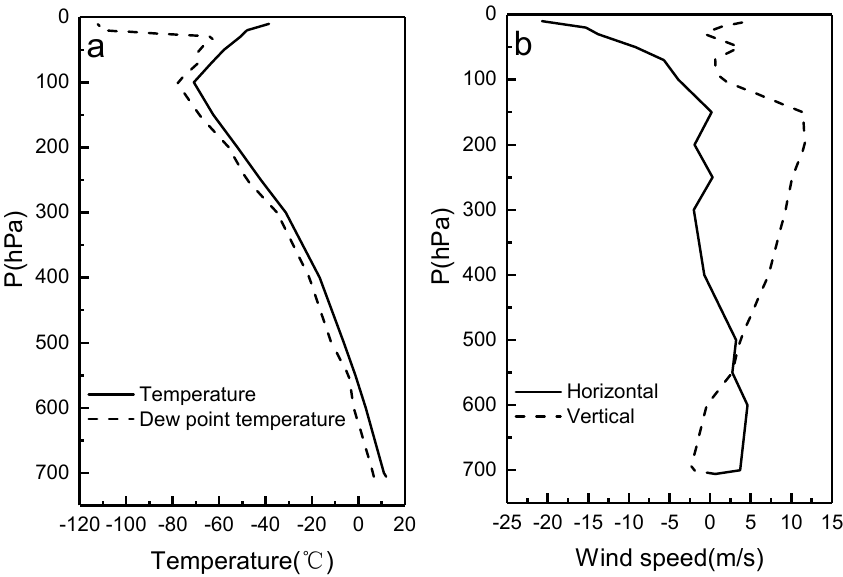
Figure 1. Environment temperature and humidity stratification ( a ) and vertical wind profile ( b ); ( a ) the black solid line represents the environment temperature, the dashed line represents the dew point; ( b ) the black solid line represents horizontal wind, and the dashed line represents vertical wind.